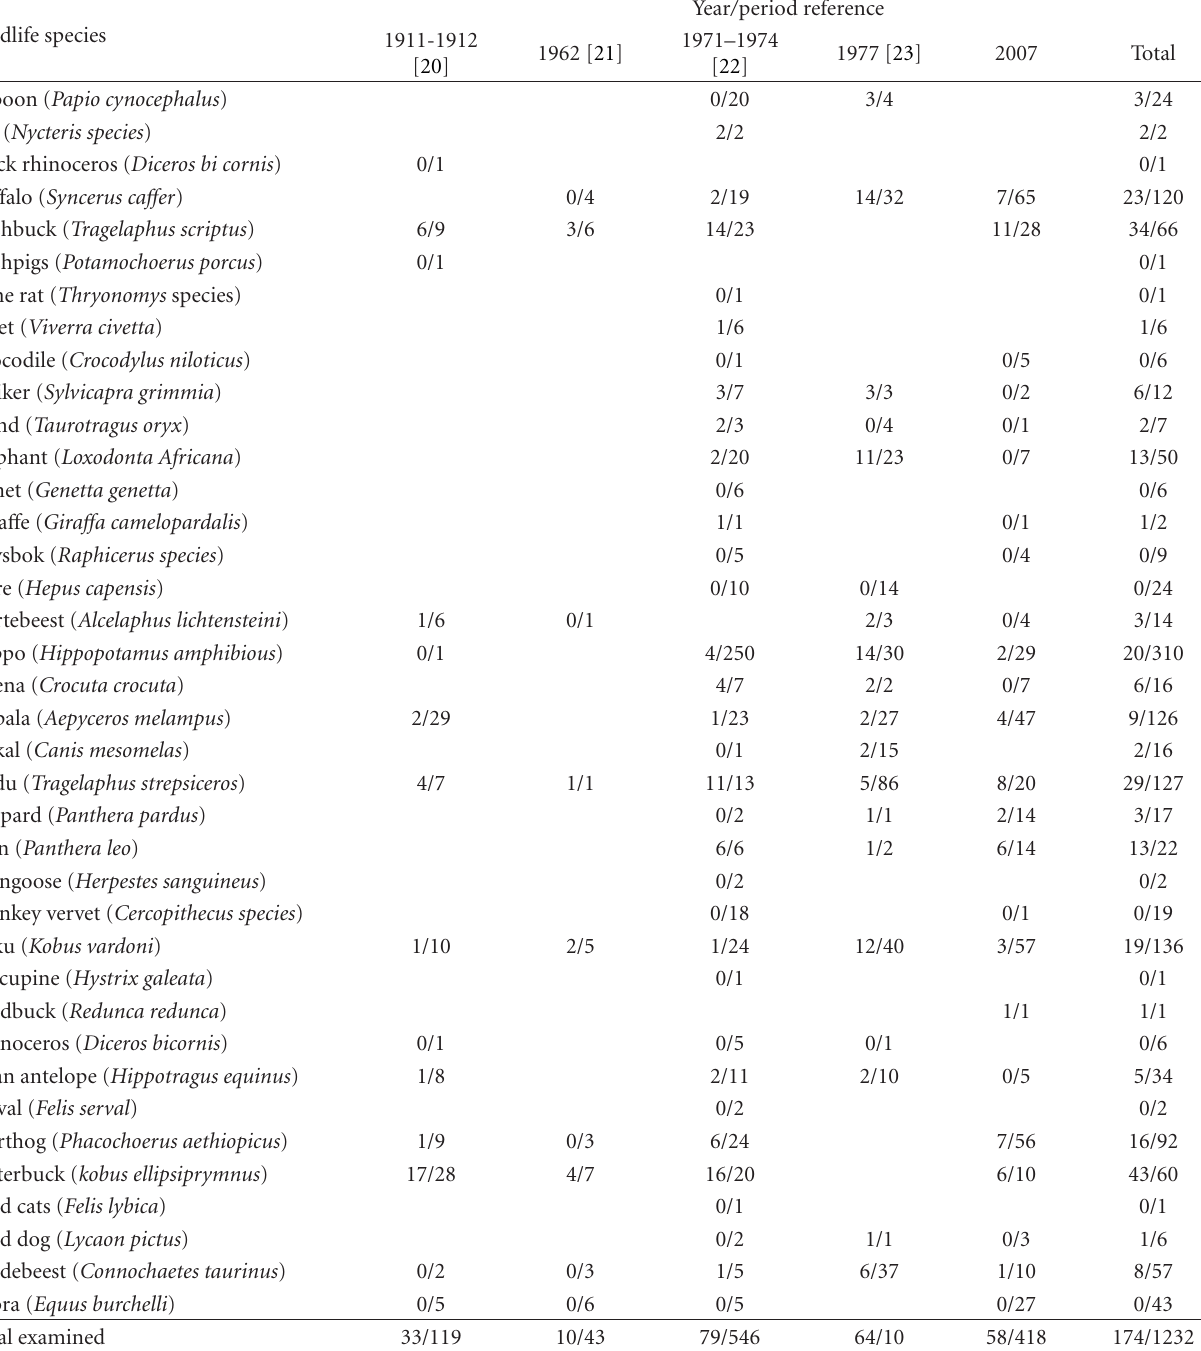
Table 1: Wildlife species tested for the presence of